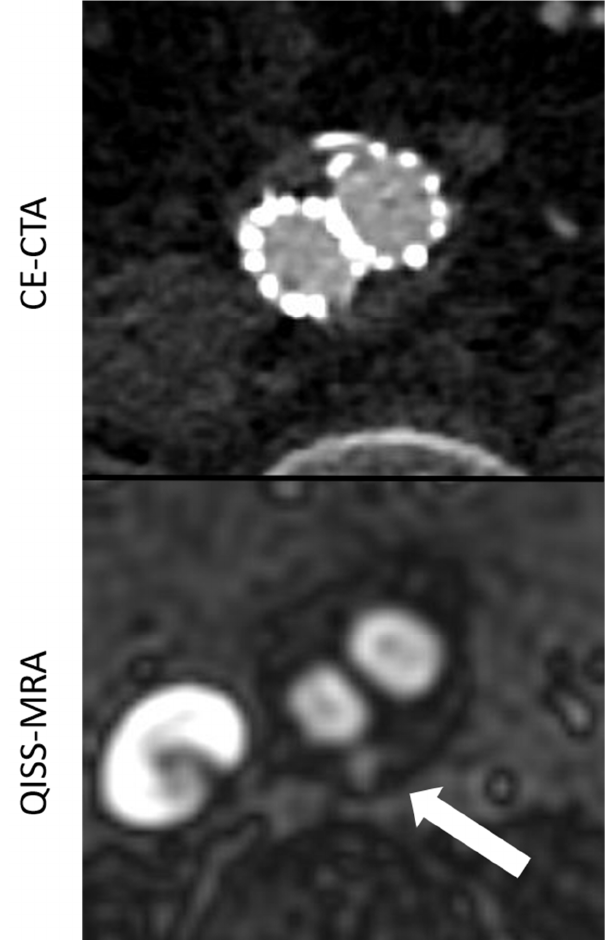
Figure 2. Comparison between CE ‐ CTA and 2D non ‐ CE radial QISS ‐ MRA concerning the visuali ‐ zation of a type II endoleak. This endoleak could only be detected in QISS ‐ MRA—which is most likely due to low ‐ flow characteristics of the endoleak (white